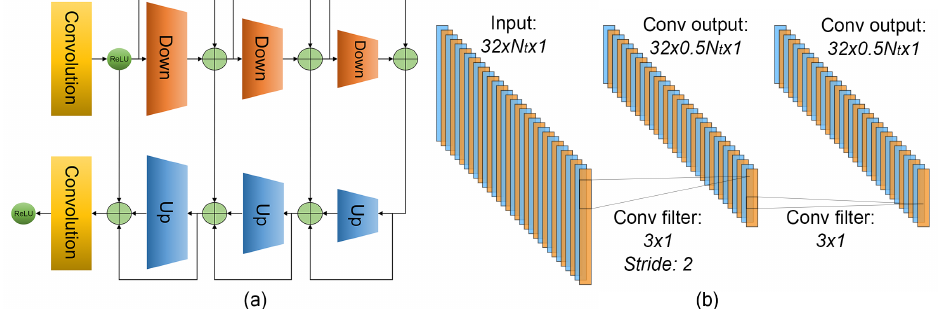
Figure 1. ( a ) Network layers of convolutional down/upsampling configuration. ( b ) Architecture of single downsampling